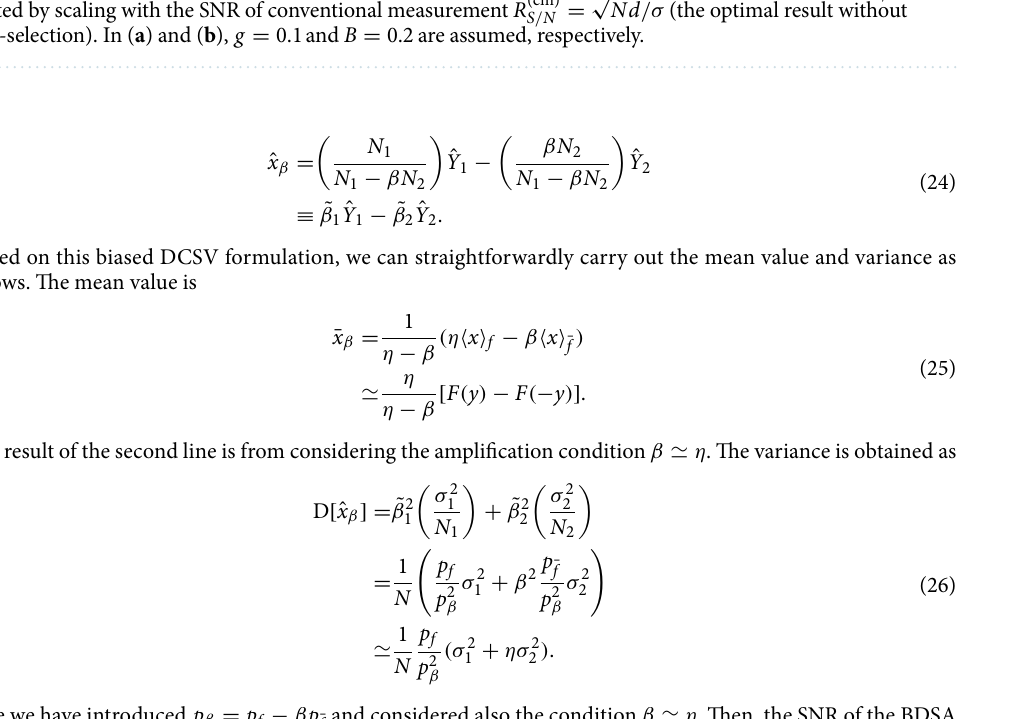
R S / N / R (cm) R S / N S / N are = (cm) √ Nd /σ (the optimal result without S / N = 0.1 and B 0.2 are assumed, (cid:31) = =